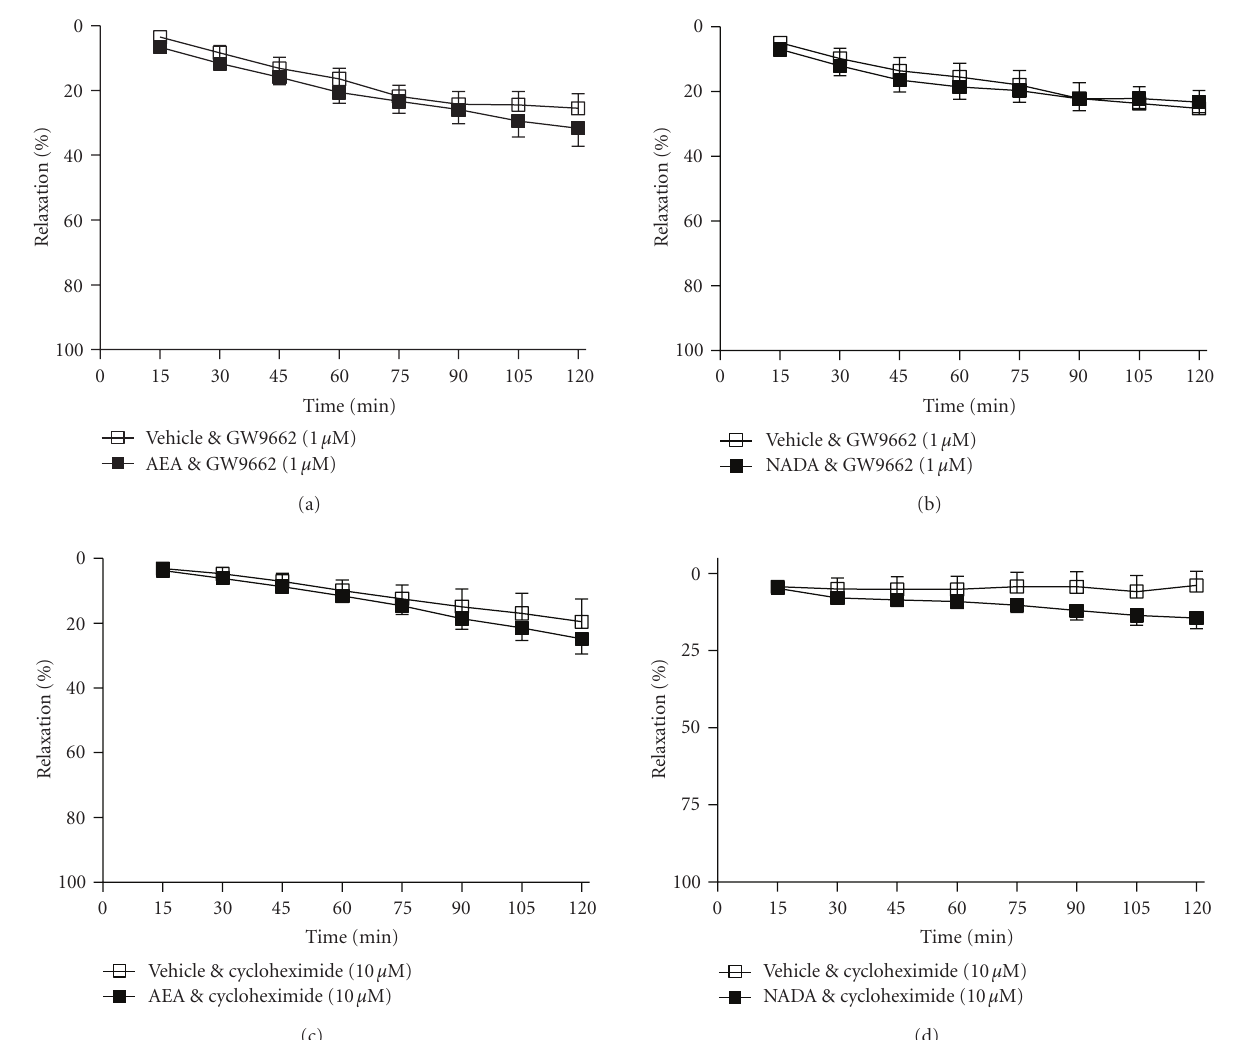
Figure 3: The e ff ects of the PPAR γ antagonist GW9662 (1 μ M, (a), and (b)) and the protein synthesis inhibitor, cycloheximide (10 μ M, (c), and (d)) on vasorelaxation to anandamide and NADA. Data are given as means with error bars representing